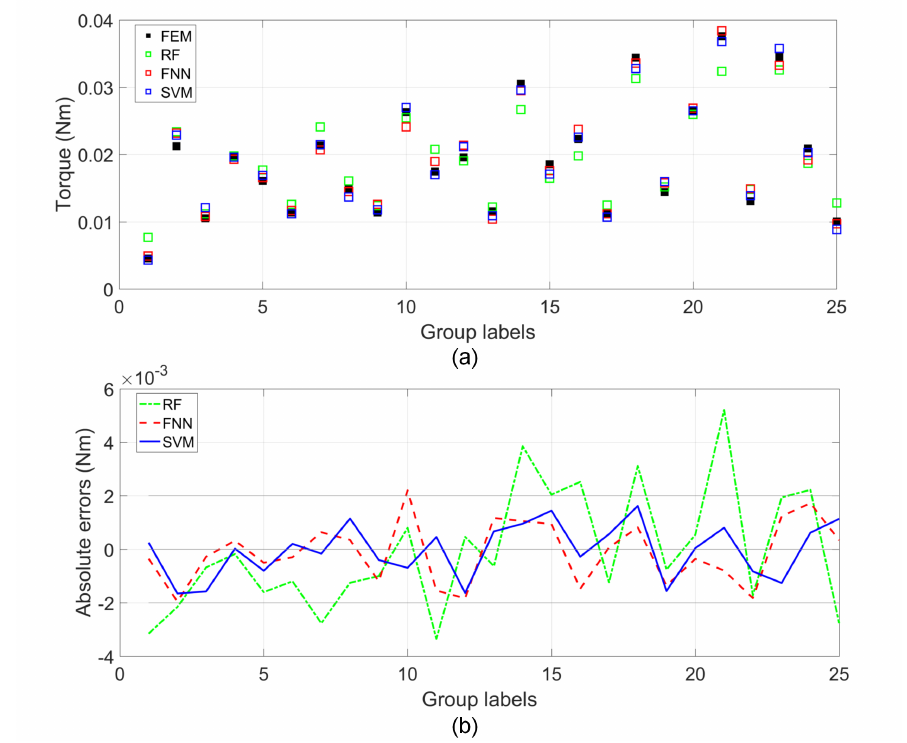
Figure 8. RF, FNN and SVM models prediction performance with test data: ( a ) torque predictions and ( b ) absolute